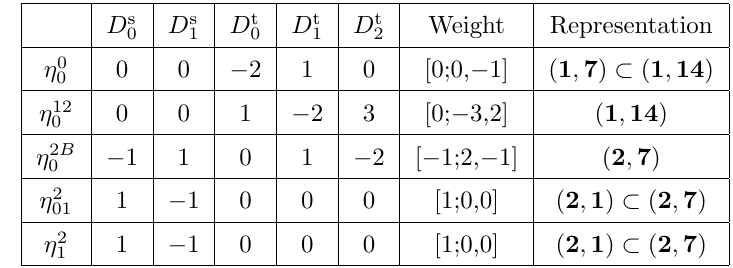
Figure 10 . Codimension-two Collision of SU(2) (cid:2) G of type III (cid:3) (with dual graph e E 7 ) with contracted nodes.